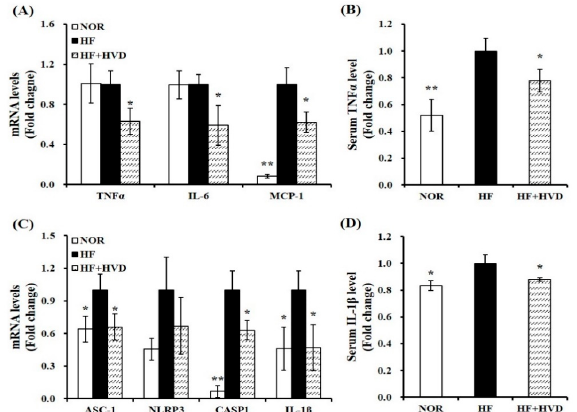
Figure 5. Effect of vitamin D supplementation on pro-inflammatory cytokines and NLRP3 inflam- masome. mRNA levels related to ( A ) pro-inflammatory cytokines and ( C ) NLRP3 inflammasome components in epididymal white adipose tissue (eWAT) were measured by RT-qPCR, normalized to β -actin, and expressed as the fold change compared to the HF group. Serum levels of ( B ) TNF α and ( D ) IL-1 β were quantified using commercial colorimetric ELISA kits, normalized to their re- spective protein concentrations, and presented as the fold change compared to the HF group. Values are expressed as the mean ± SEM ( n = 9/group). NOR, 10% fat diet with 1000 IU vitamin D; HF, 60% fat diet with 1000 IU vitamin D; HF + HVD, 60% fat diet with 10,000 IU vitamin D. * p < 0.05; ** p < 0.01 compared to the HF group.